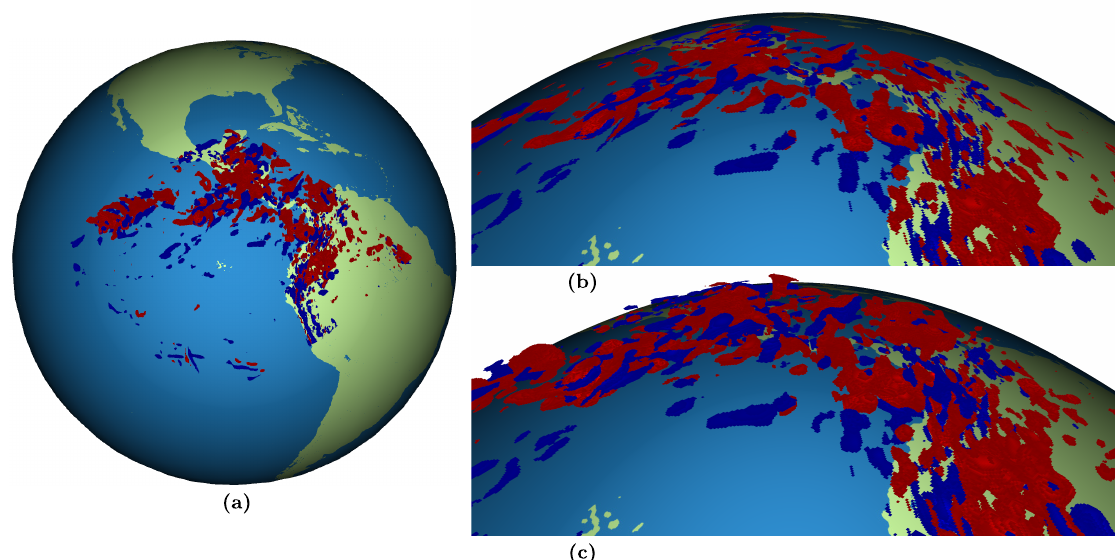
Figure 15. Vertical wind speed (mbar/s) sampled into a 3D DGGS at resolution 9. Negative velocity, which corresponds to an upward wind, is shown in red. Positive velocity, which corresponds to a downward wind, is shown in blue. Velocities with a magnitude less than 0.25 mbars/s are not shown to reduce clutter and highlight regions with the highest speeds. In ( a , c ), the altitude of cells is scaled by a factor of 15 to better show changes in altitude. In ( b ), altitude is shown at its true